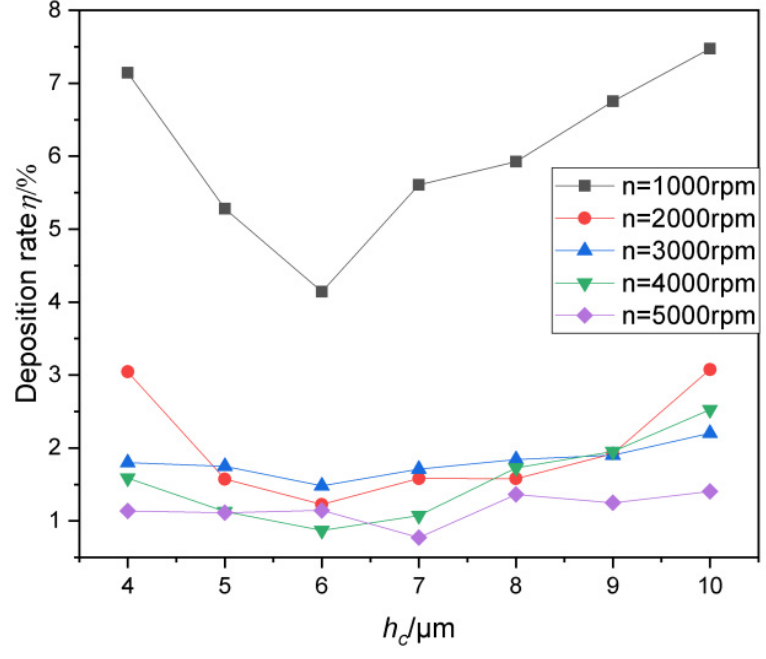
Figure 9. Influence of groove depth on the deposition rate.